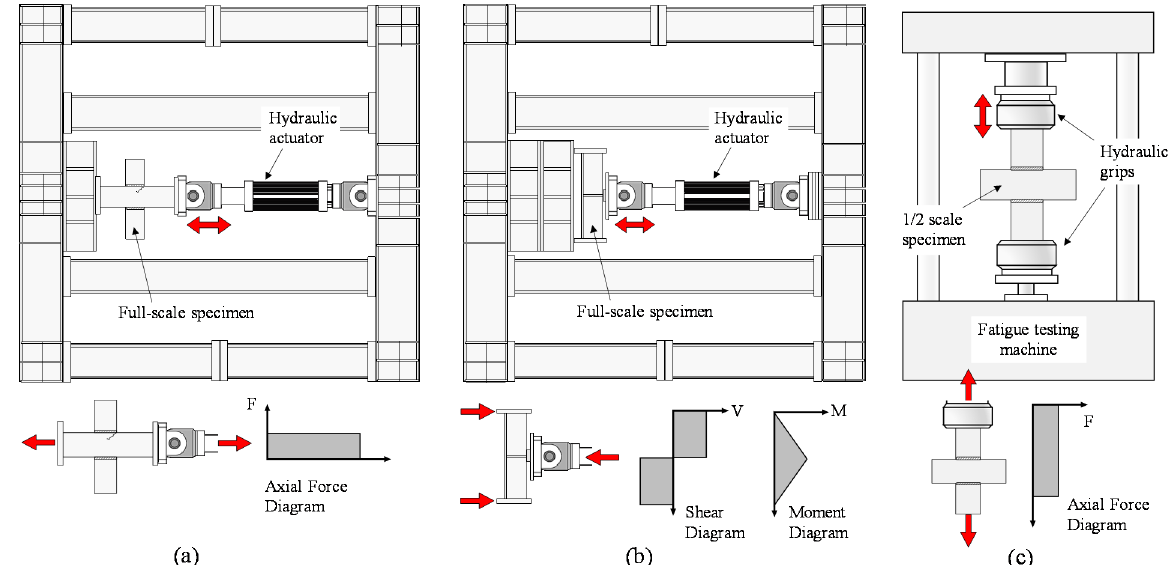
Figure 27. Experimental test setup and specimen force diagrams for a ( a ) full-scale axially loaded specimen, ( b ) full-scale specimen with three-point bending, and ( c ) half-scale axially loaded specimen.